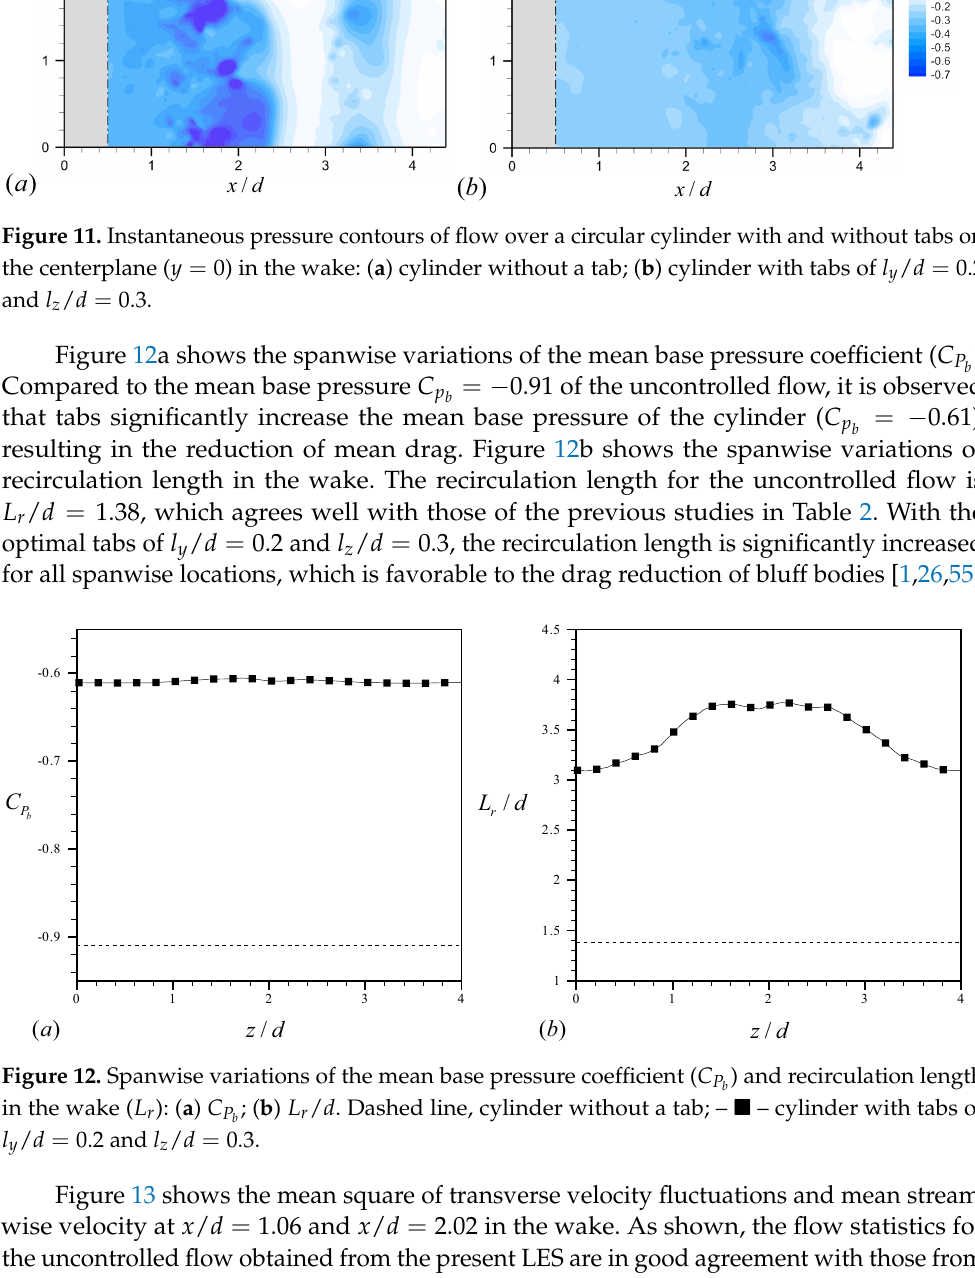
) and recirculation length b